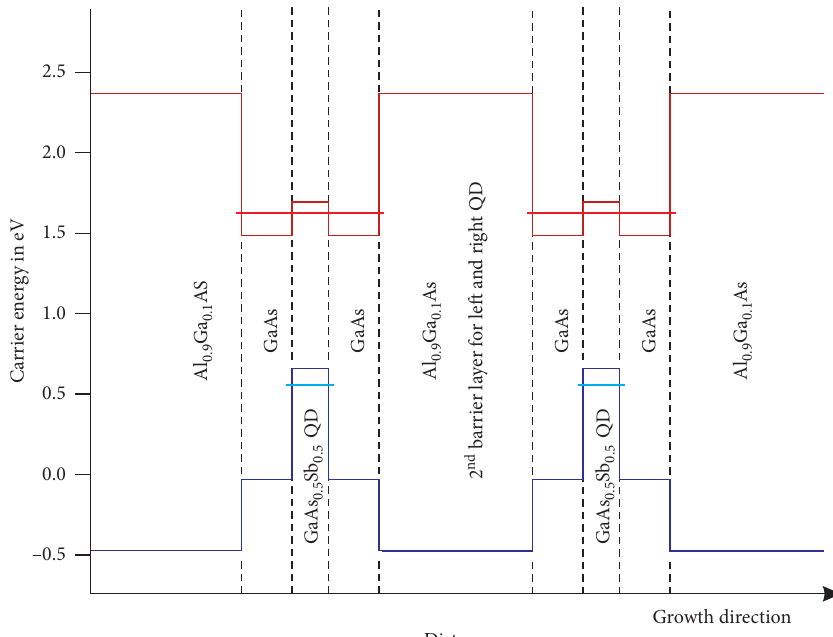
Figure 7: Energy level/band diagram of a GaAs 0.5 Sb 0.5 QD in between pure GaAs capsule layers, and those in between Al 0.9 Ga 0.1 As layers (flat band conditions including stress/strain). Now electrons have a bound state due to the GaAs-layers. The capsule layers are assumed to have a thickness of 20nm each. For the QDs a pyramidal shape and a base width of 25nm and a height of 3nm are assumed.